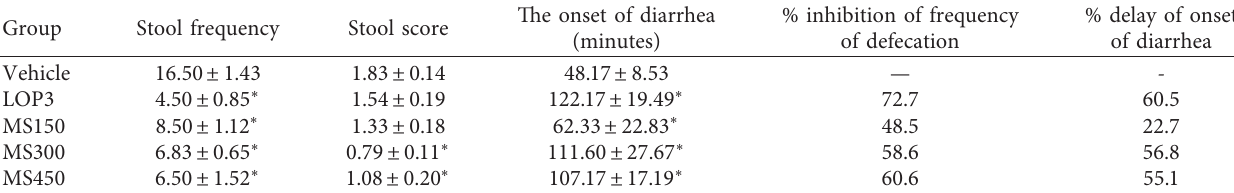
Table 1: The effect of 80% methanol leaf extract of M. stenopetala in the castor oil-induced diarrhea model. The onset of Group Stool frequency Stool score